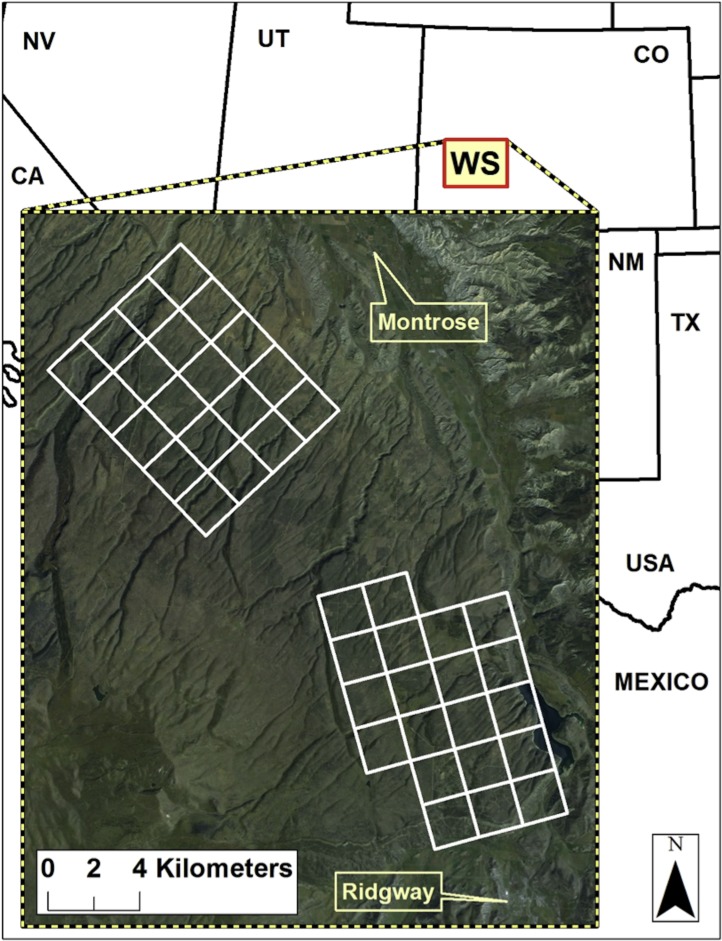
Location of the study site on the Western Slope, Colorado, USA.The camera survey was completed in 2009 across 40 grid cells covering 160 km2, with one camera per cell.